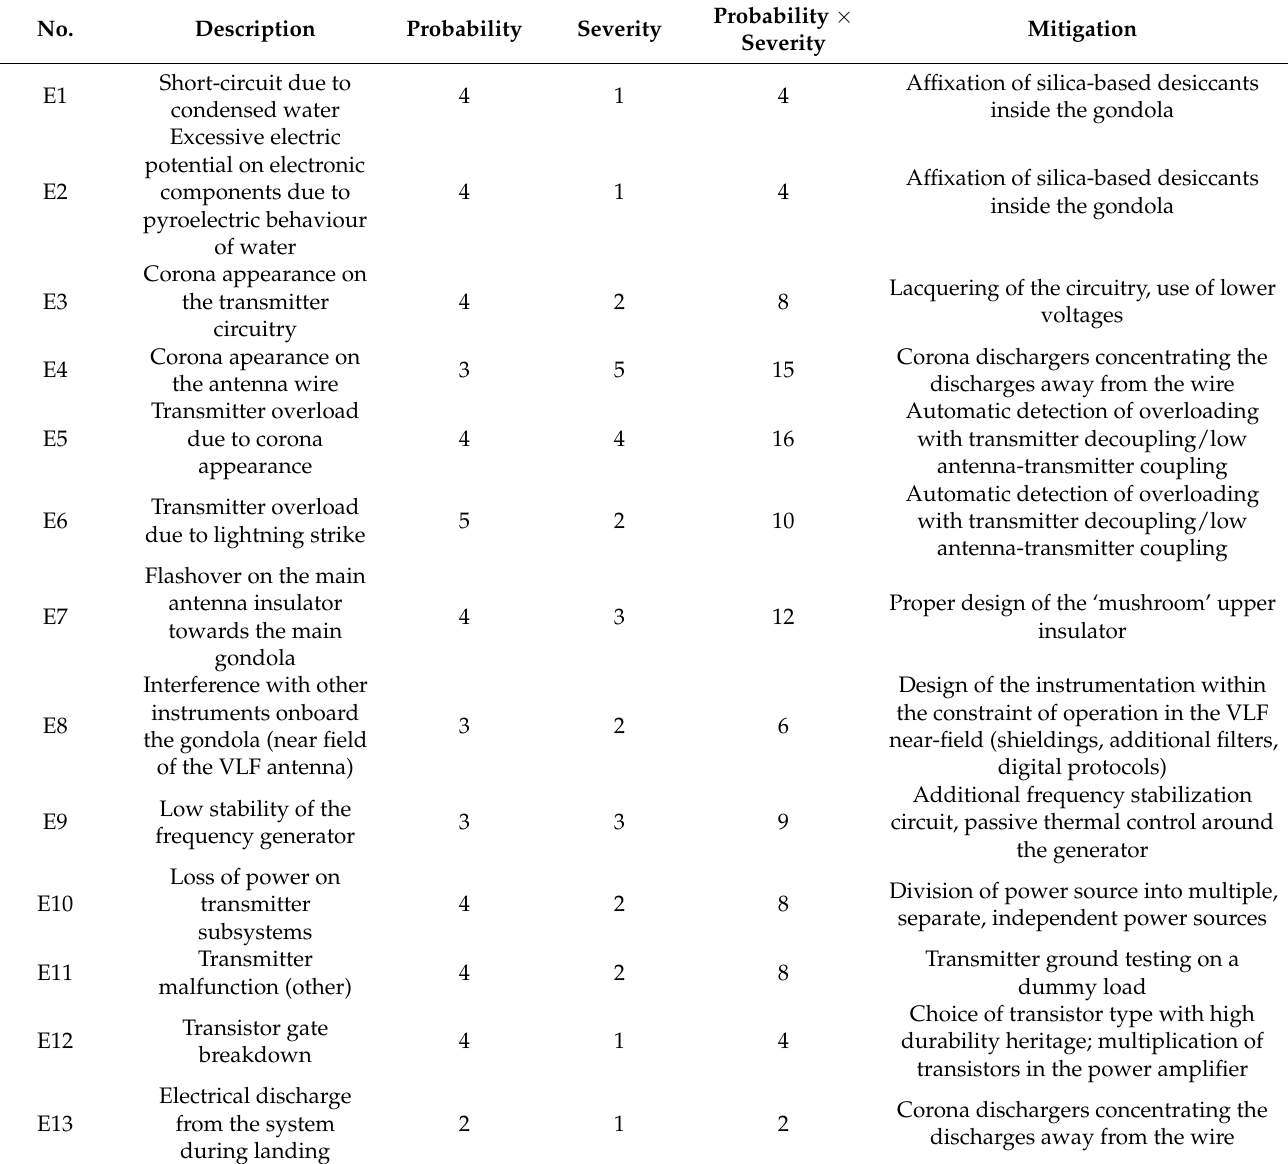
Table 4. Electrical risks for a stratospheric fully airborne VLF light balloon